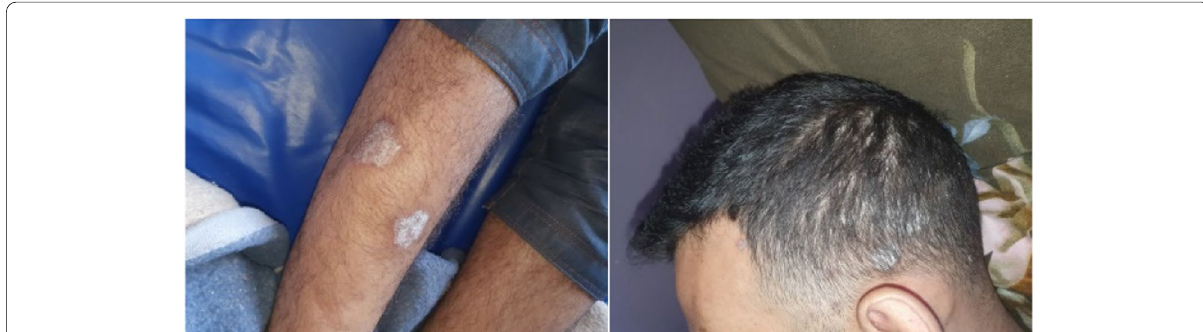
Fig. 1 Erythematous plaques with silvery squames on extensor surface of the knees and scale